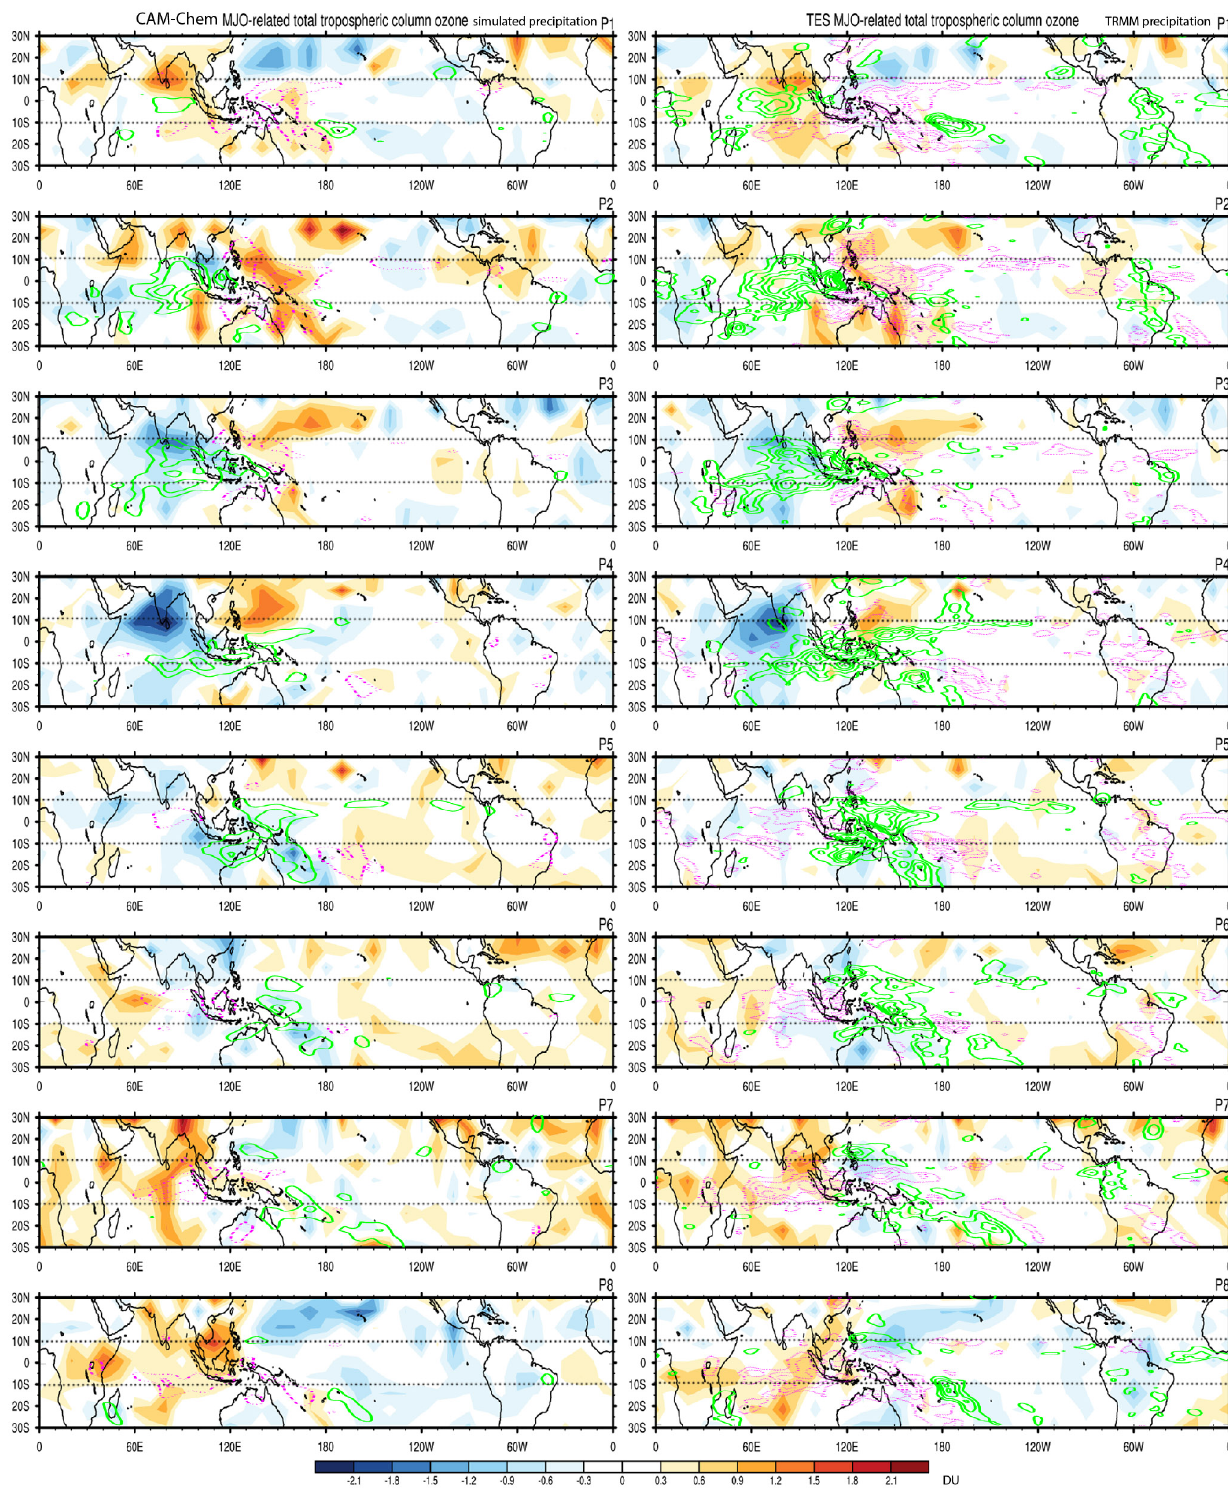
Figure 5. Left: composite life cycle (phase 1 to 8) of the MJO-related total tropospheric column ozone (color, in DU) for CAM-chem (with the TES operator applied) with precipitation (green lines as positive and purple lines as negative); right: composite life cycle of the MJO- related TTC ozone for TES (color, in DU) with TRMM precipitation (green lines as positive and purple lines as negative) for 30 ◦ S to 30 ◦ N. The precipitation is contoured from − 3 to 3mmday − 1 with 0.5mmday − 1